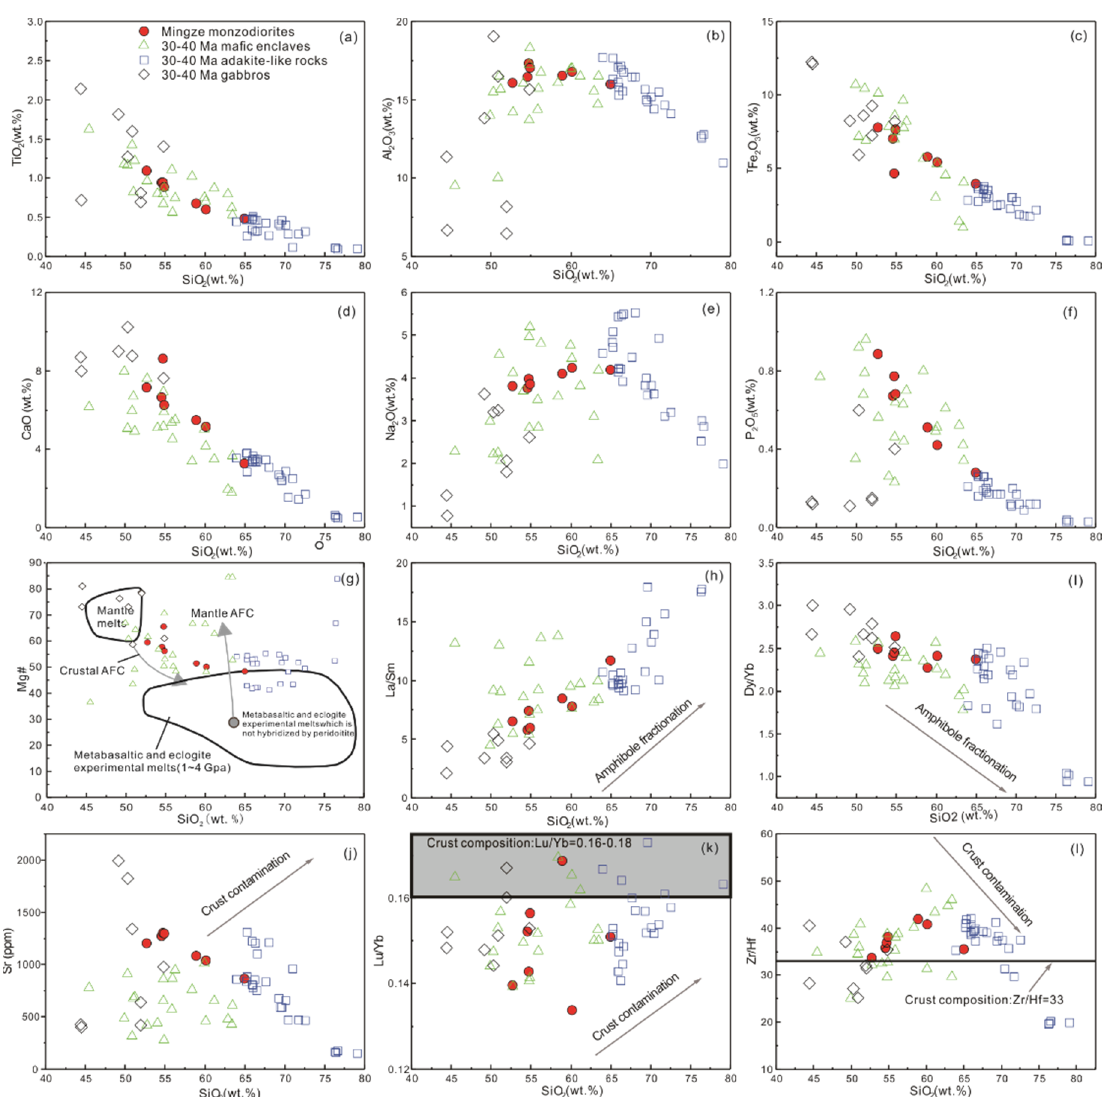
Figure 7. Selected elements and their ratios plot for the Mingze monzodiorites. SiO 2 versus ( a ) TiO 2 , ( b ) Al 2 O 3 , ( c ) T Fe 2 O 3 , ( d ) CaO, ( e ) Na 2 O, ( f ) P 2 O 5 , ( g ) Mg#, ( h ) La/Sm ratio, ( i ) Dy/Yb ratio, ( j ) Sr, ( k ) Lu/Yb ratio and ( l ) Zr/Hf ratio. Modify after [43]. Data sources are the same as in Figure 4.